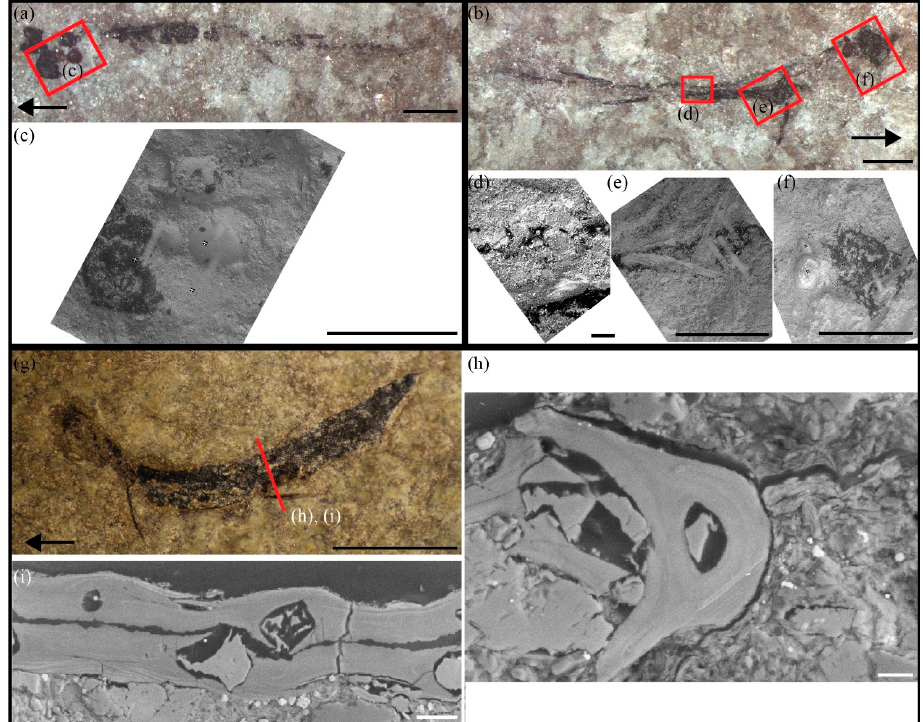
Figure 1. Figure 1. Cont.